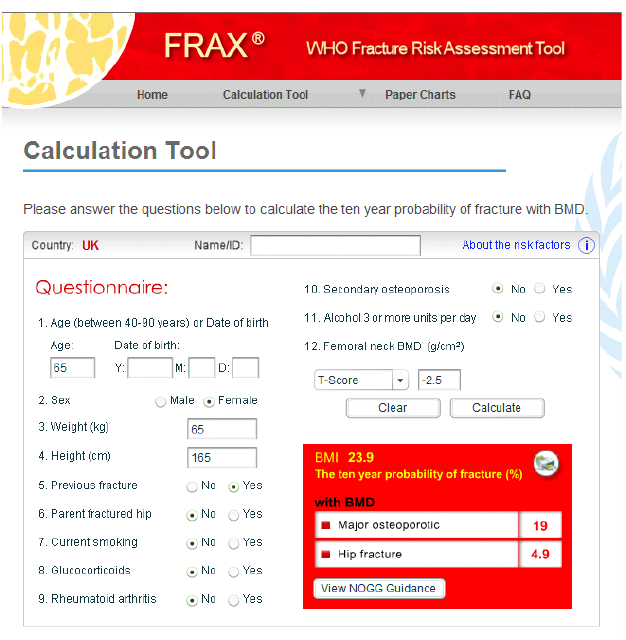
Figure. Screen page of the UK version of the FRAX ®